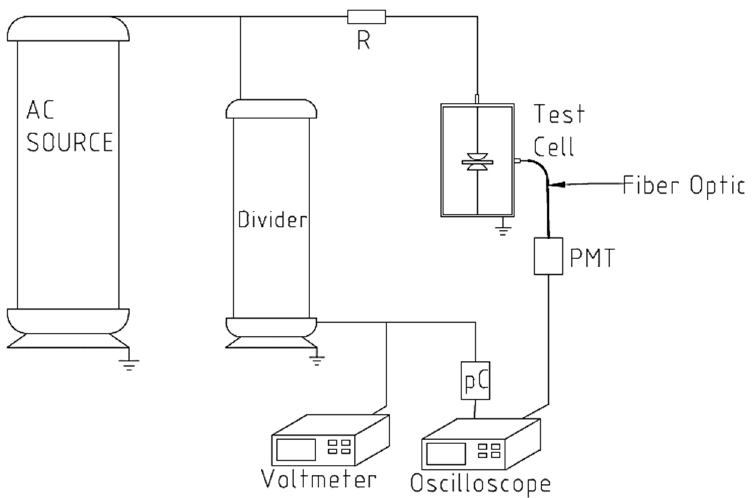
Figure 3. Experimental setup used during the measurements: R—limiting resistor, pC—quadrupole, PMT—photomultiplier.